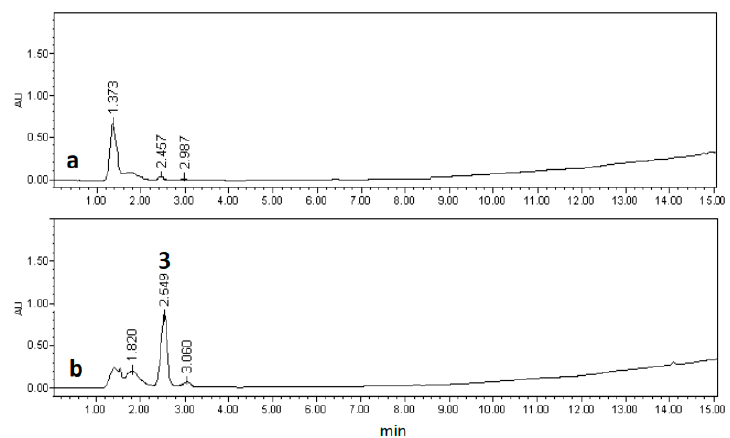
Figure 3. HPLC profiles of ( a ) CH 2 Cl 2 :CH 3 OH extract and ( b ) Fraction C1F3 obtained from hairy root line LRT 7.31.